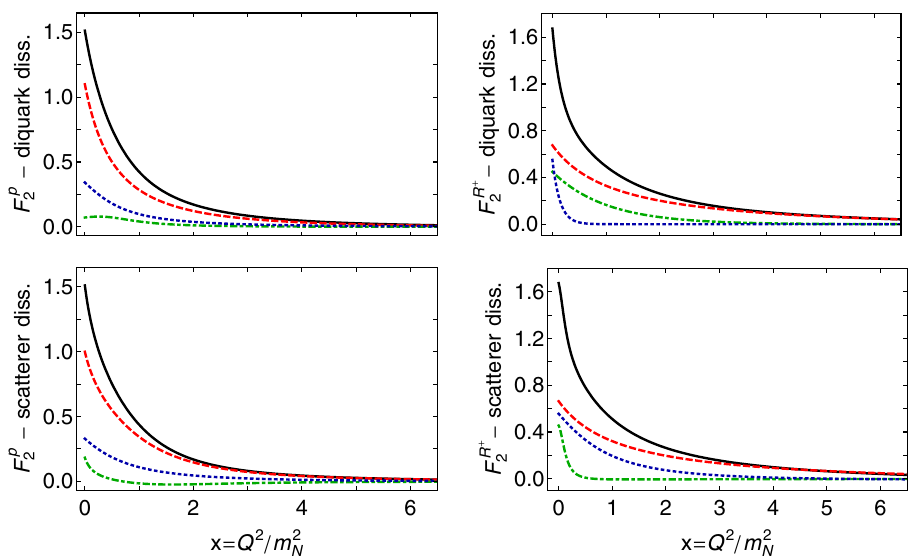
Figure 5. Pauli form factors of the proton and charged-Roper. Upper panels – diquark breakdown: DD1 (dashed red), scalar diquark in initial and final baryon; DD2 (dot-dashed green), pseudovector diquark in both initial and final states; DD3 (dotted blue), scalar diquark in incoming baryon, pseudovector diquark in outgoing baryon, and vice versa. Lower panels – scatterer breakdown: DS1 (red dashed), photon strikes an uncorrelated dressed quark; DS2 (dot-dashed green), photon strikes a diquark; and DS3 (dotted blue), diquark breakup contributions, including photon striking exchanged